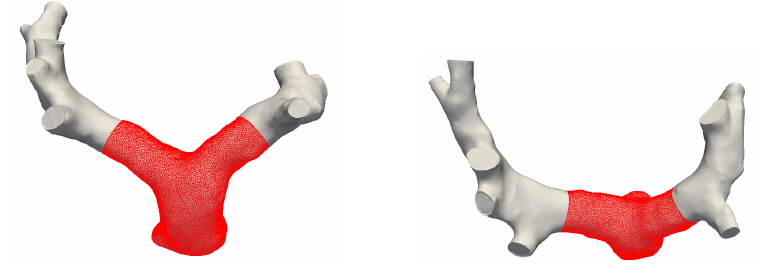
Figure A1. Front and top views of full and cropped (in red) models for Subject